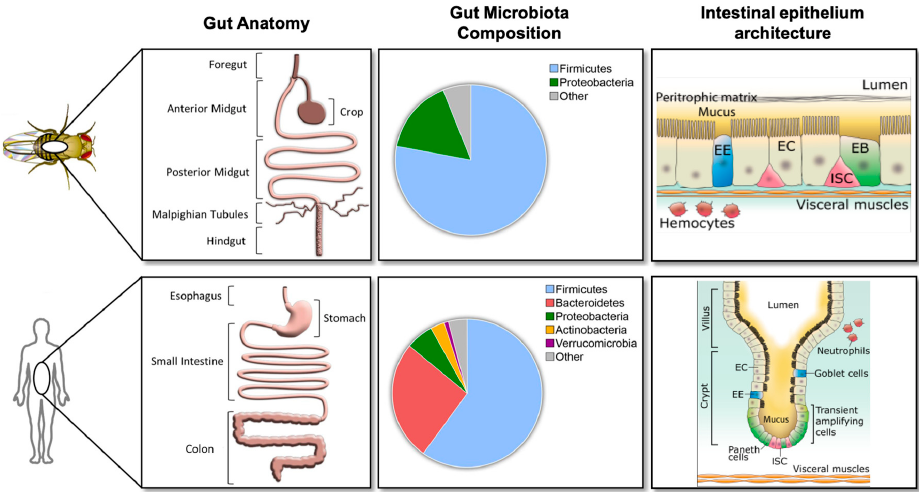
Figure 2. Comparisons between Drosophila melanogaster and human gut anatomy, gut bacterial microbiota, and intestinal epithelium. Left panel: Gut anatomy of Drosophila melanogaster and humans. Drosophila midgut and hindgut are functional analogs of the human small intestine and colon, respectively (extracted and modified from Figure 1 of [20]). Middle panel: Taxonomical distribution data for top phyla in Drosophila melanogaster and humans (extracted from Figure 1 of [20]). Right panel: Intestinal epithelium is surrounded by visceral muscles and composed of intestinal stem cells (ISCs) in red, undi ff erentiated ISC daughters in green (enteroblasts (EBs)), enterocytes (ECs) in beige and enteroendocrine cells (EEs) in blue. Under normal conditions, the gut microbiota is localized within the lumen. Barriers such as the peritrophic membrane within Drosophila melanogaster and the mucus within humans prevent direct contact between intestinal epithelial cells and gut